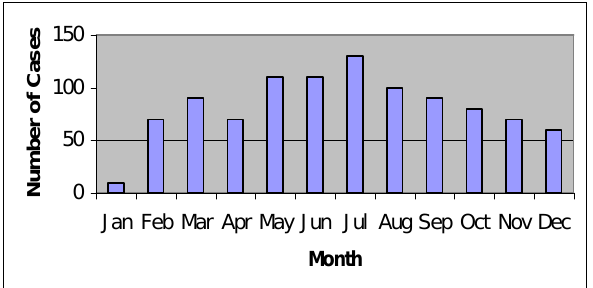
Figure 1: State of Louisiana campylobacter average annual cases by seasonal distribution for years 1988- 2001(LDHH 2001).